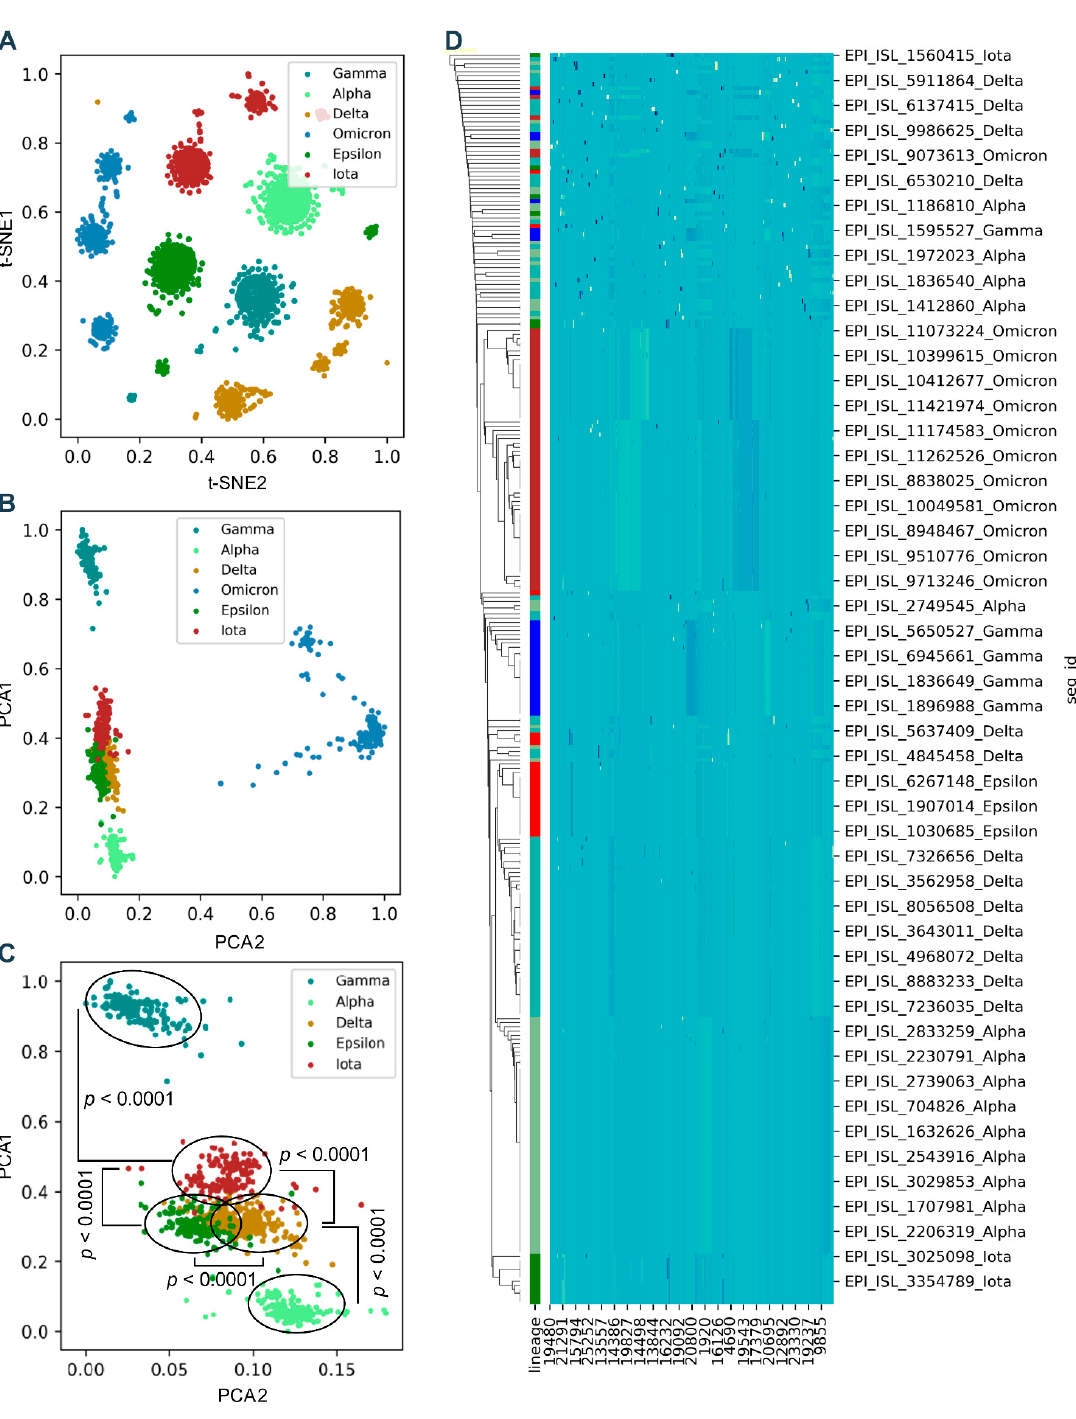
Figure 2. Projection of sequential AA frequency in Spike with t-SNE and PCA. Plot of two components reduced by t-SNE from 1273 × 20 features ( A ). The plot represents the PCA1/PCA2 ratio of the absolute difference value for truncated data between the 20% and 80% quantiles. PCA1 and PCA2 were affined in space with the data point of the least PCA1 value as the coordinate origin and were then calculated for simple linear regression for Spike genes with ( B ) or without ( C ) Omicron variants, respectively. The hierarchical clustering diagram of Alpha, Delta, Omicron, and other VOCs/VOIs ( D ). Statistical significance in the PCA1 value difference between two neighboring VOCs/VOIs is indicated, respectively, according to an unpaired, nonparametric Mann–Whitney